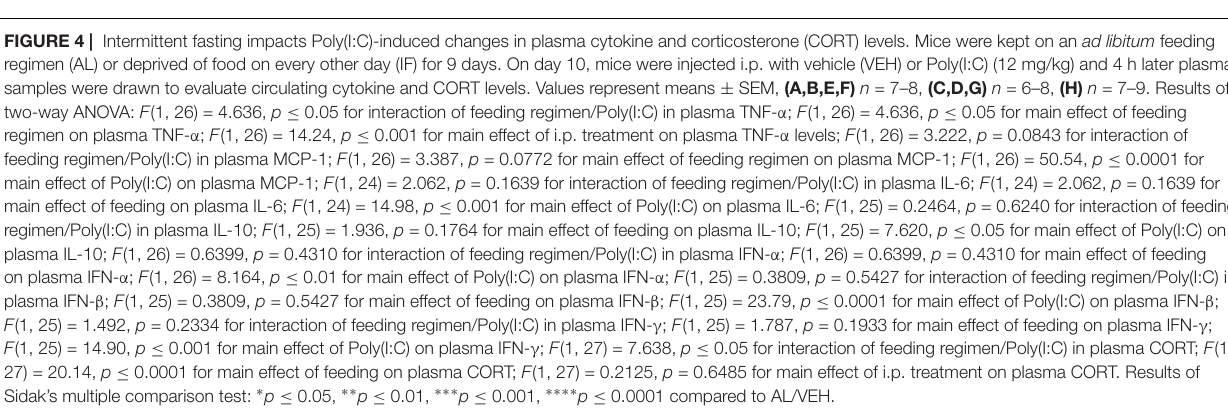
FIGURE 4 | Intermittent fasting impacts Poly(I:C)-induced changes in plasma cytokine and corticosterone (CORT) levels. Mice were kept on an ad libitum feeding regimen (AL) or deprived of food on every other day (IF) for 9 days. On day 10, mice were injected i.p. with vehicle (VEH) or Poly(I:C) (12 mg/kg) and 4 h later plasma samples were drawn to evaluate circulating cytokine and CORT levels. Values represent means ± SEM, (A,B,E,F) n = 7–8, (C,D,G) n = 6–8, (H) n = 7–9. Results of two-way ANOVA: F (1, 26) = 4.636, p ≤ 0.05 for interaction of feeding regimen/Poly(I:C) in plasma TNF- α ; F (1, 26) = 4.636, p ≤ 0.05 for main effect of feeding regimen on plasma TNF- α ; F (1, 26) = 14.24, p ≤ 0.001 for main effect of i.p. treatment on plasma TNF- α levels; F (1, 26) = 3.222, p = 0.0843 for interaction of feeding regimen/Poly(I:C) in plasma MCP-1; F (1, 26) = 3.387, p = 0.0772 for main effect of feeding regimen on plasma MCP-1; F (1, 26) = 50.54, p ≤ 0.0001 for main effect of Poly(I:C) on plasma MCP-1; F (1, 24) = 2.062, p = 0.1639 for interaction of feeding regimen/Poly(I:C) in plasma IL-6; F (1, 24) = 2.062, p = 0.1639 for main effect of feeding on plasma IL-6; F (1, 24) = 14.98, p ≤ 0.001 for main effect of Poly(I:C) on plasma IL-6; F (1, 25) = 0.2464, p = 0.6240 for interaction of feeding regimen/Poly(I:C) in plasma IL-10; F (1, 25) = 1.936, p = 0.1764 for main effect of feeding on plasma IL-10; F (1, 25) = 7.620, p ≤ 0.05 for main effect of Poly(I:C) on plasma IL-10; F (1, 26) = 0.6399, p = 0.4310 for interaction of feeding regimen/Poly(I:C) in plasma IFN- α ; F (1, 26) = 0.6399, p = 0.4310 for main effect of